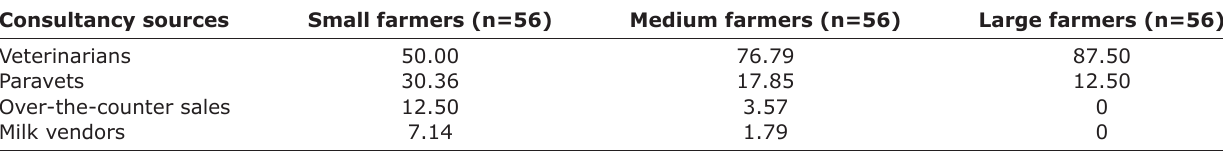
Table-1: Distribution of farmers as per sources of veterinary consultancy (n=168). Consultancy